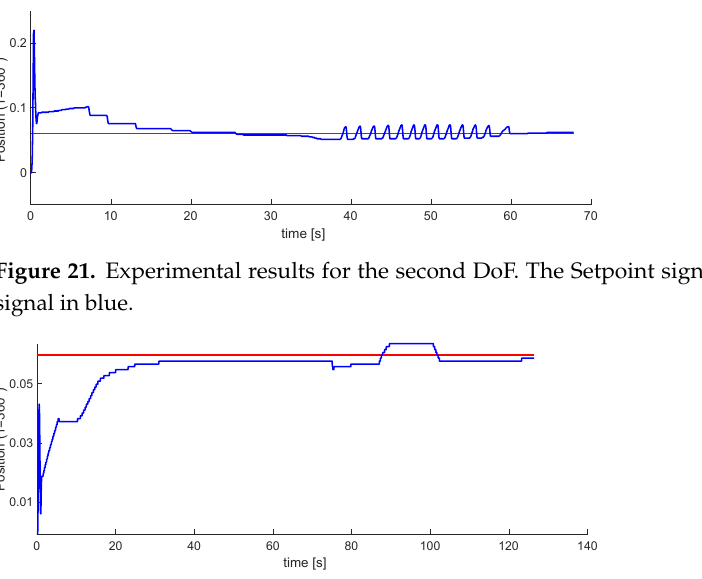
Figure 22. Experimental results for the third DoF. The Setpoint signal is colored in red, control signal in blue.